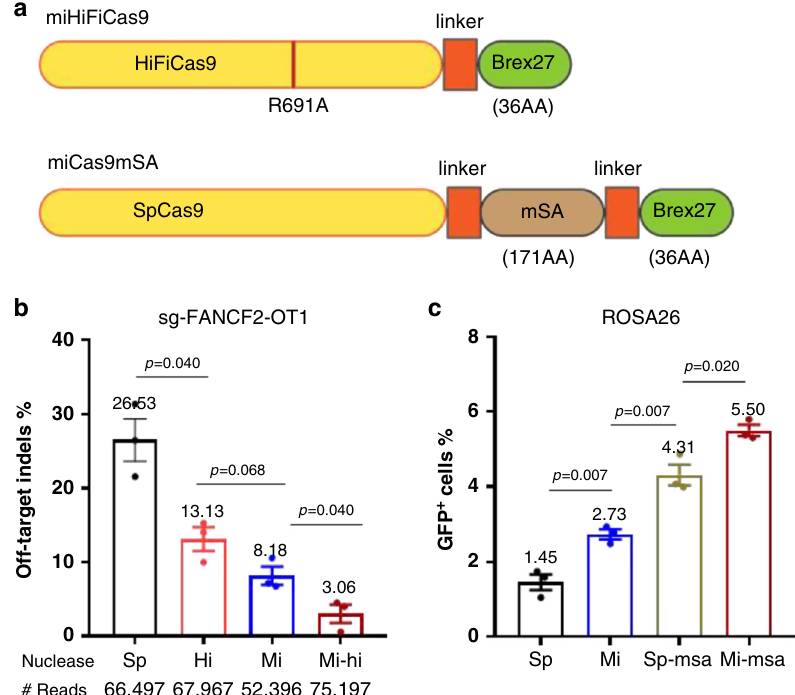
Fig. 5 Brex27 serves as a plug and play module. a Illustration of the miHiFiCas9 and miCas9mSA design. b Off-target indel rates of sg-FANCF2 by spCas9, HiFiCas9, miCas9, or miHiFiCas9. c Percentage of GFP + cells after GFP ds-KI at the ROSA26 locus using spCas9, miCas9, spCas9mSA, or miCas9mSA. Sp: spCas9, Mi: miCas9, Hi: HiFiCas9, Mi-hi: miHiFiCas9, Sp-msa: spCas9mSA, Mi-msa: miCas9mSA. # Reads: Average amplicon reads per sample. Three independent experiments were performed for each condition. Data are presented as mean ± standard error of means (SEM). Unpaired t- test (two-tailed) was used to compare data using GraphPad Prism 8 software (GraphPad Software, Inc., San Diego, CA). Source data are available in the Source Data fi